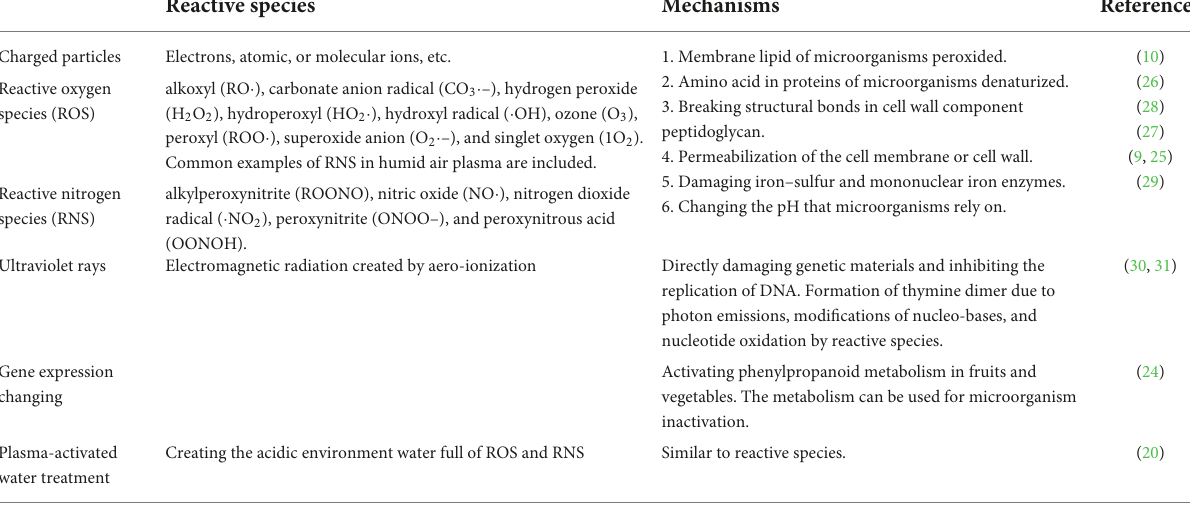
TABLE 1 Mechanisms of microbial decontamination by cold plasma (CP) in